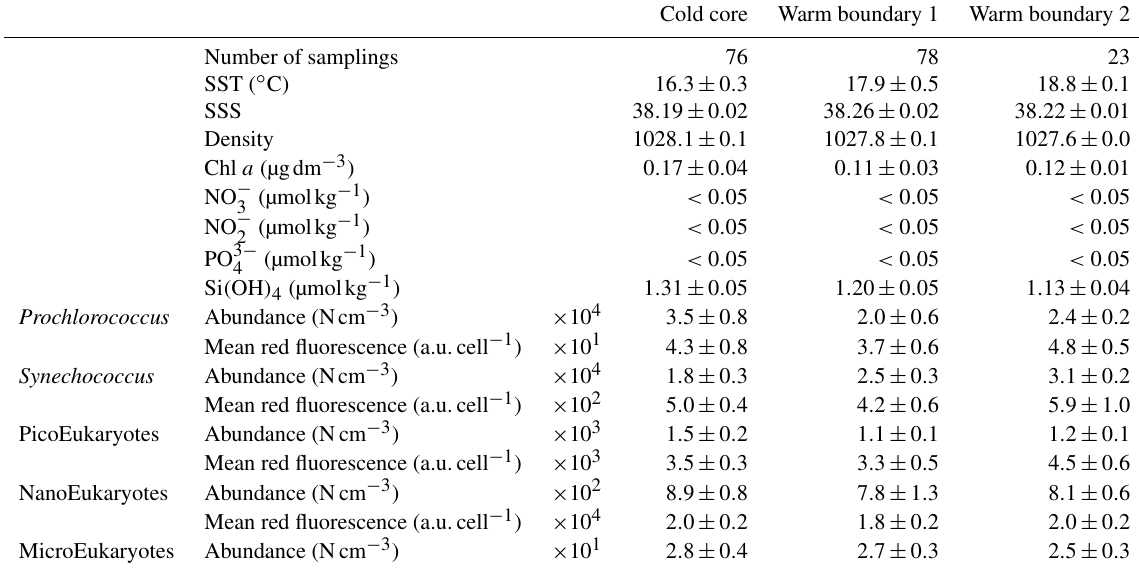
Table 1. Mean and SD values of SST, SSS, density, Chl a , nitrate, nitrite, phosphate and silicate in the cold core and warm boundaries 1 and 2 during the OSCAHR campaign. Prochlorococcus , Synechococcus , PicoEukaryote (PicoE, PicoHighFLR, PicoHighFLO), NanoEukaryote (NanoE, NanoFLO, NanoHighFLO) and MicroEukaryote (MicroE, MicroHighFLO) abundances are expressed in number of cells (N) per cm − 3 , and the mean red fluorescences of Prochlorococcus , Synechococcus , PicoE and NanoE are expressed in arbitrary units (a.u.) per cell for each hydrographical